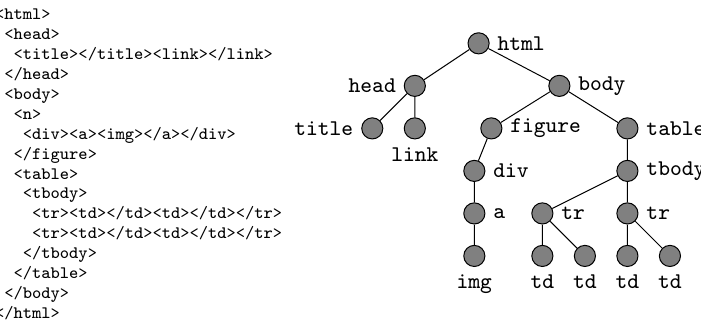
Figure 1. An HTML document and the associated DOM